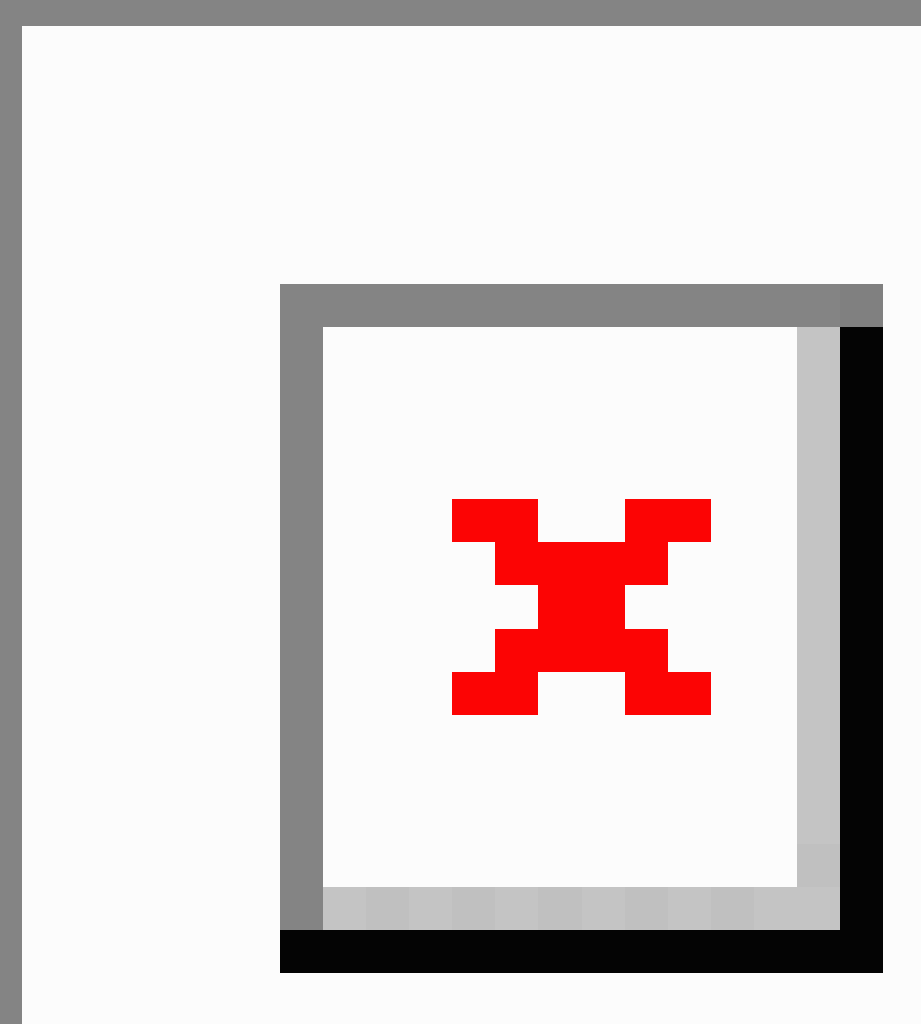
Figure 3. Pretests and posttests scores on clinical